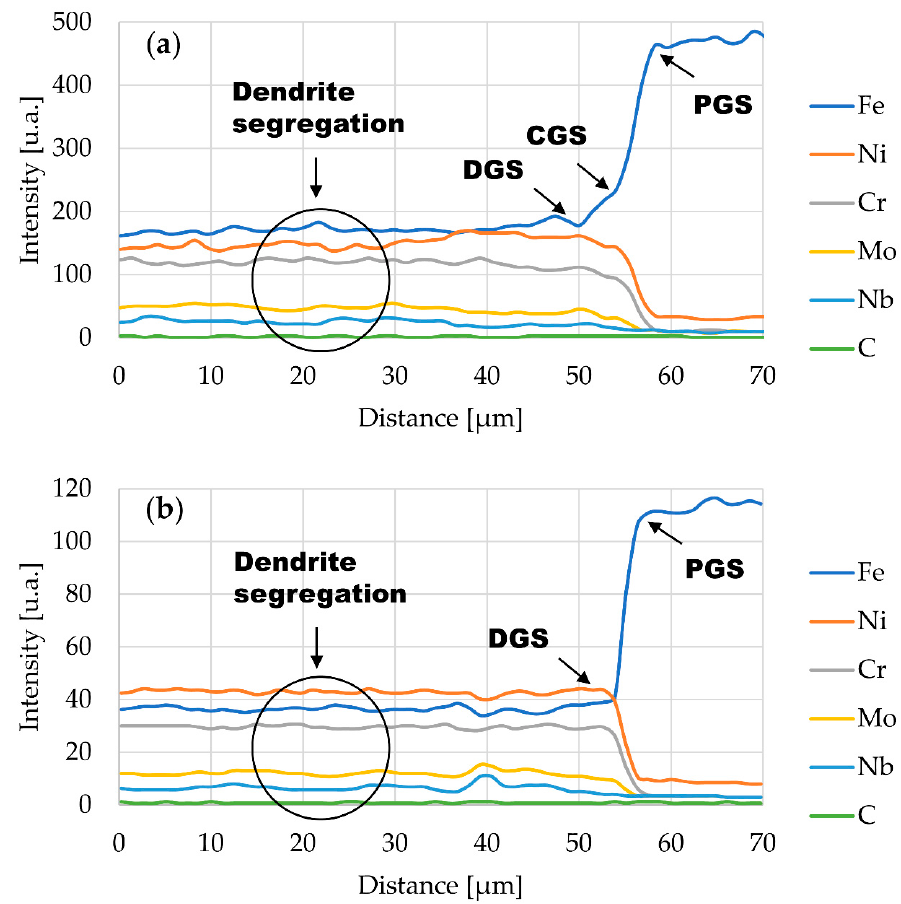
Figure 7. Line scan energy dispersive spectroscopy (EDS) of the transition zone of the substrate/clad containing grains with boundary type I ( a ) and type II ( b